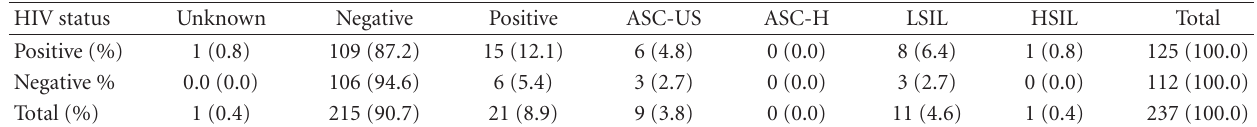
Table 1: Association between HIV status and cytology